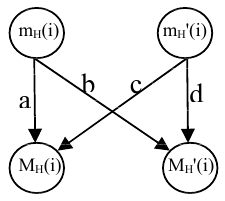
Fig 7: Creation of next generation of